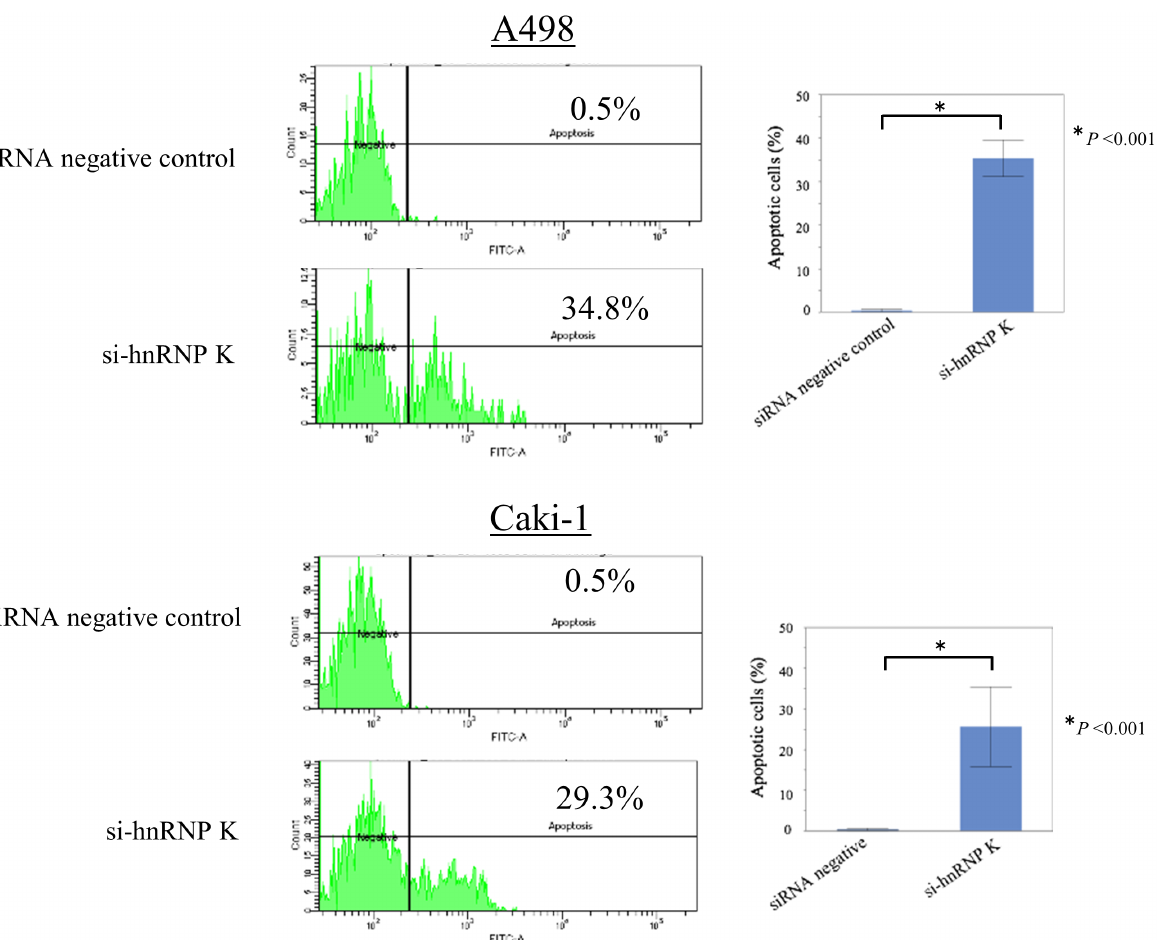
Fig 2. Induction of apoptosis by hnRNP K knocking down in RCC cells. Measurement of apoptotic cells in A498 (upper panel) and Caki-1 (lower panel) cell lines transfected with control siRNA or si-hnRNP K using flow cytometry. Three individual experiments were performed, and the percentage of apoptotic cells in these cell lines is presented as means ± s.d. * P < 0.05 compared with control (Student ’ s t -test, n =